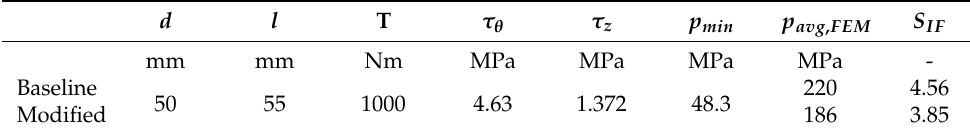
Table 2. Input data and calculated safety factors for the interference